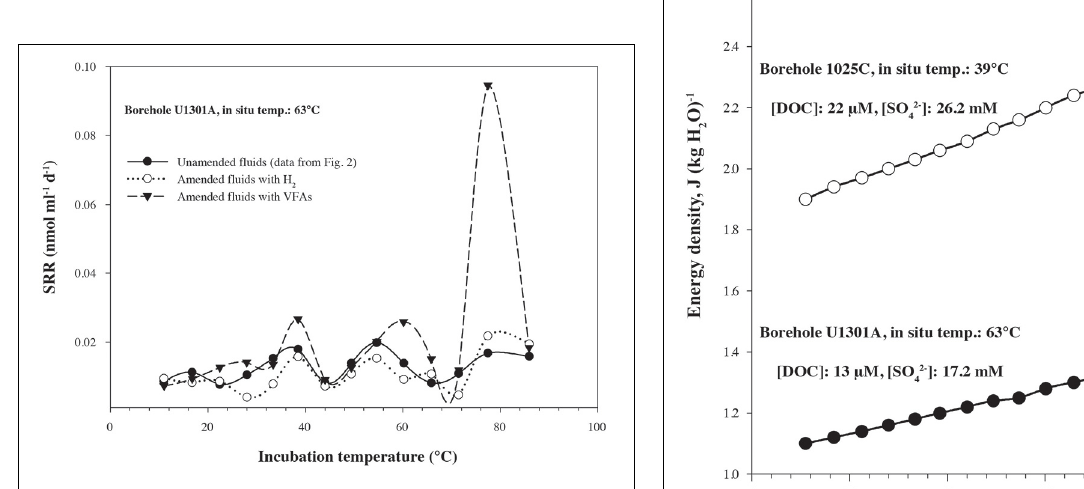
FIGURE 3 | Sulfate reduction rates, determined from temperature-gradient experiments after 3–5 days of incubation of; unamended crustal fluids collected from borehole U1301A, amended U1301A fluids with a mix of short-chain volatile fatty acids (VFAs) at 1mM concentration, amended U1301A fluids with hydrogen at near saturation. Data points represent the average of two experimental replicates.